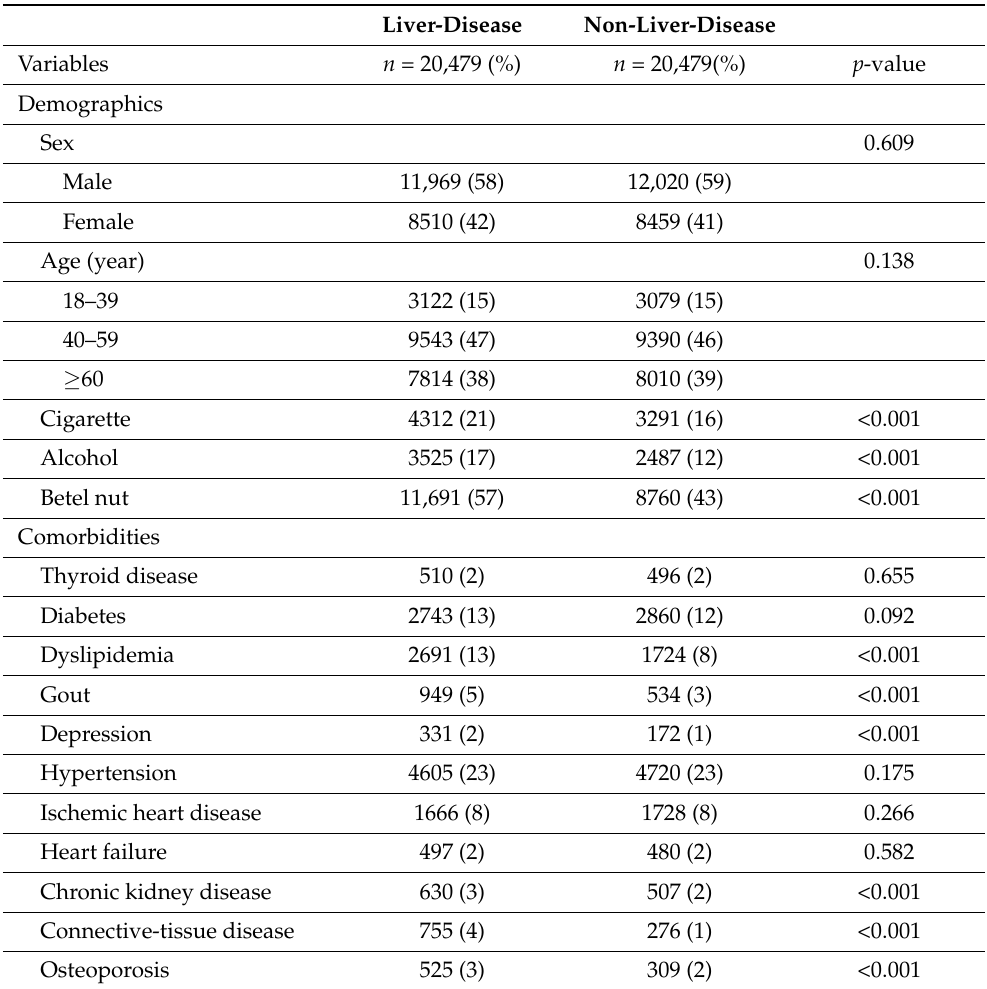
Table 1. Demographic characteristics at baseline.